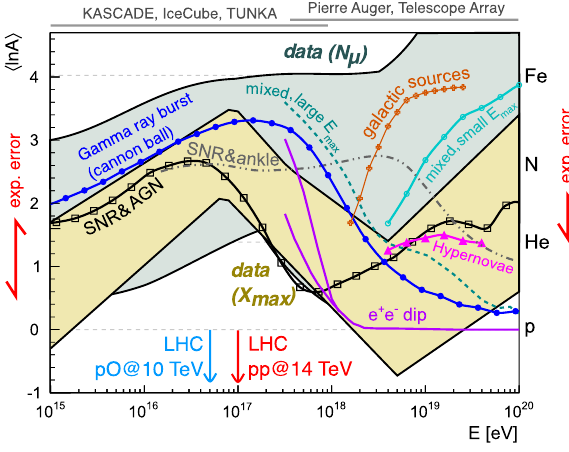
Figure 1. Mass composition of cosmic rays quantified by (cid:104) ln A (cid:105) as a function of cosmic-ray energy E . Model predictions (mark- ers and lines) are compared to data bands, all taken from the review by Kampert and Unger [1]. Vertical arrows at the sides indicate the instrumental error achieved by leading experiments at low and high energies. The figure is discussed in the